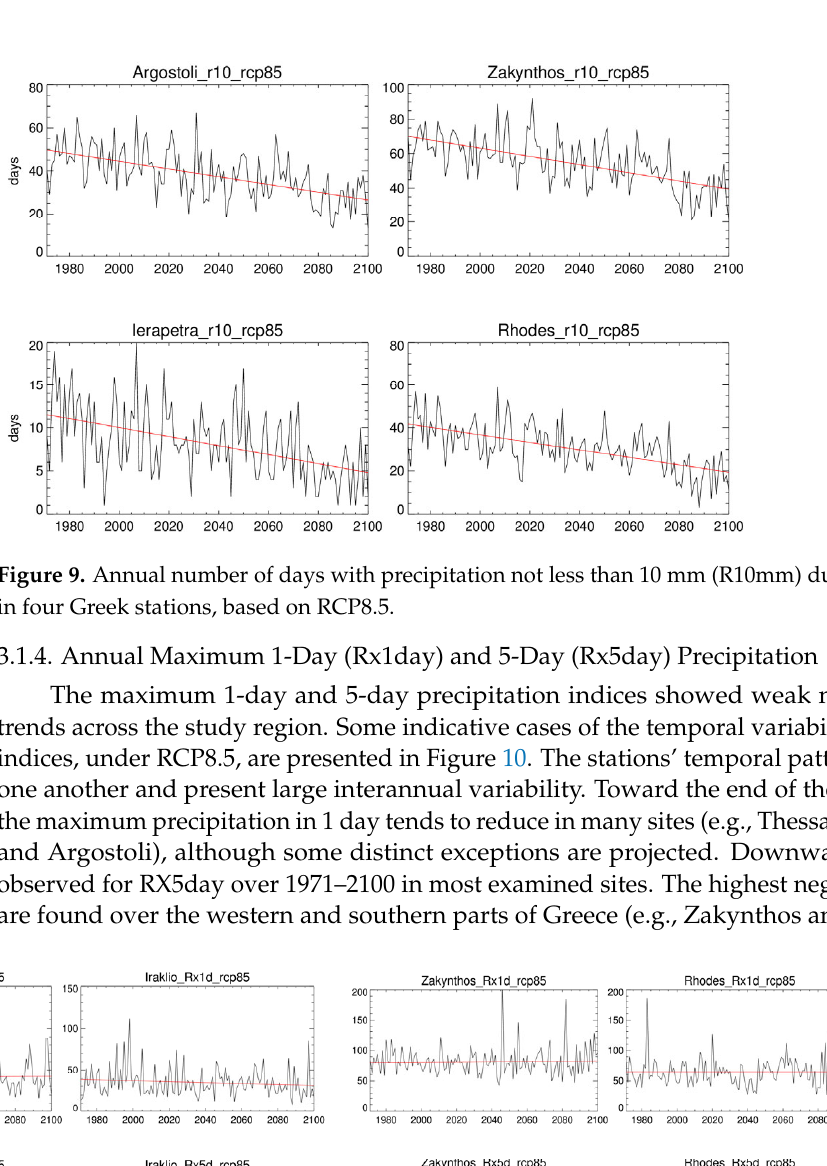
Figure 11. Annual total precipitation from days with precipitation exceeding the 95th percentile (R95p) under both emission scenarios.